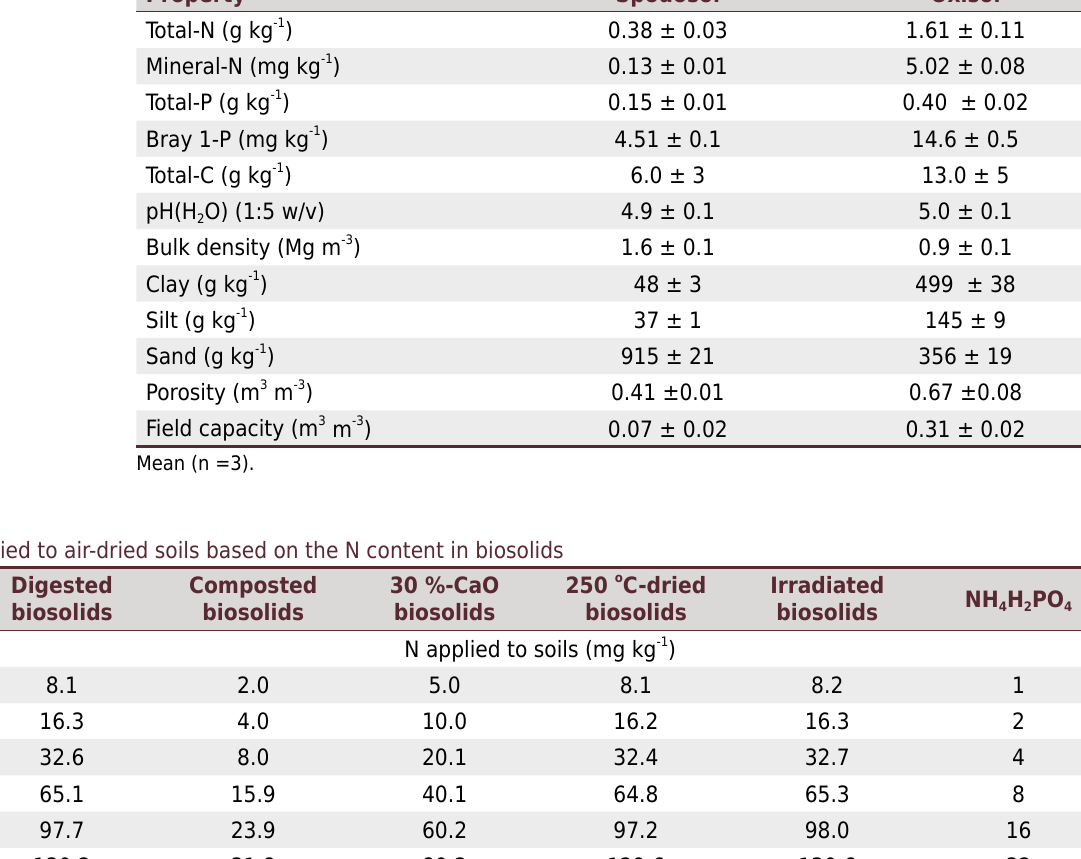
Table 2. Chemical and physical properties of the selected soils (mean ± standard error) Property